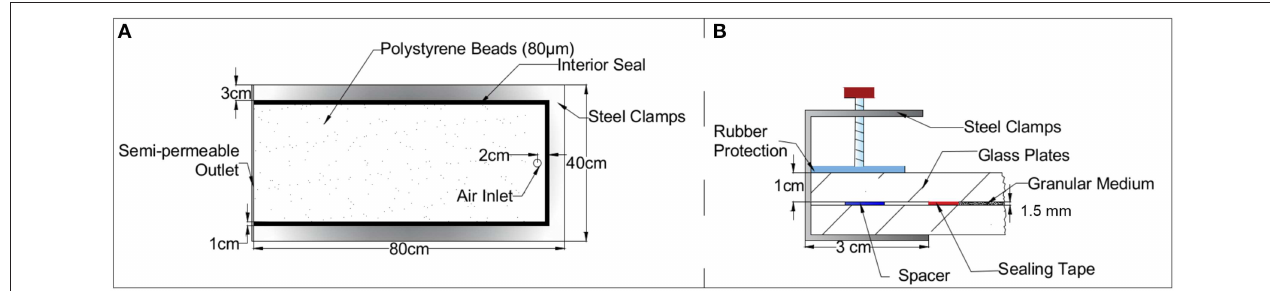
FIGURE 1 | Schematic diagram of the Hele-Shaw cell including the dimensions. (A) Top view of the Hele-Shaw cell including its dimensions. The cell is made of two glass plates which are placed on top of the other with 1.5mm spacing between them. A porous medium is placed inside the cell. Three sides of the cell are sealed and the 4th boundary is sealed with a semi-permeable filter. (B) Side view of the Hele-Shaw cell showing clamp details. To protect the glass plates from point loading, a rubber sheet is placed in between the screw and the plate. Aluminum spacers are placed in between the plates to provide equivalent spacing everywhere in the